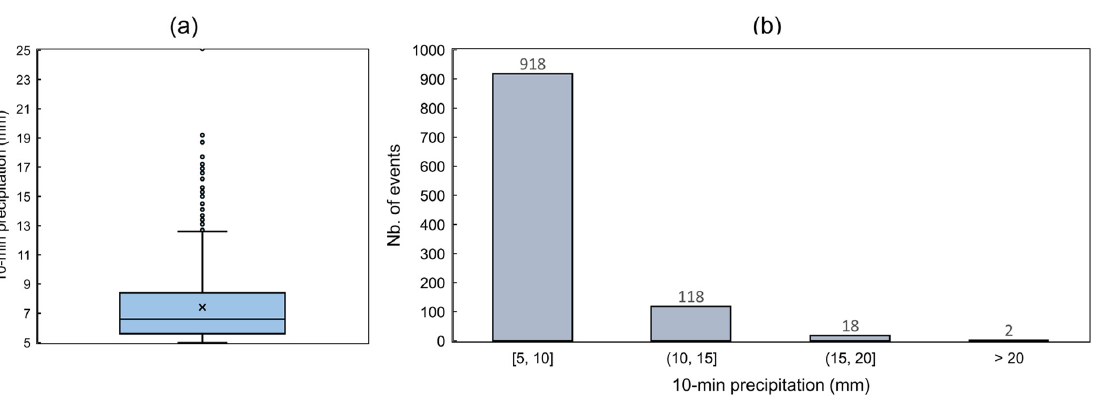
Figure 2. ( a ) Boxplot and ( b ) histogram of the precipitation totals (in mm) during the sub-hourly (10-minute) heavy precipitation events (SHHP), i.e., sub-hourly periods with precipitation equal to or above 5.0 mm (2951 events) and pooled together for the entire 71-weather-station (WS) network.